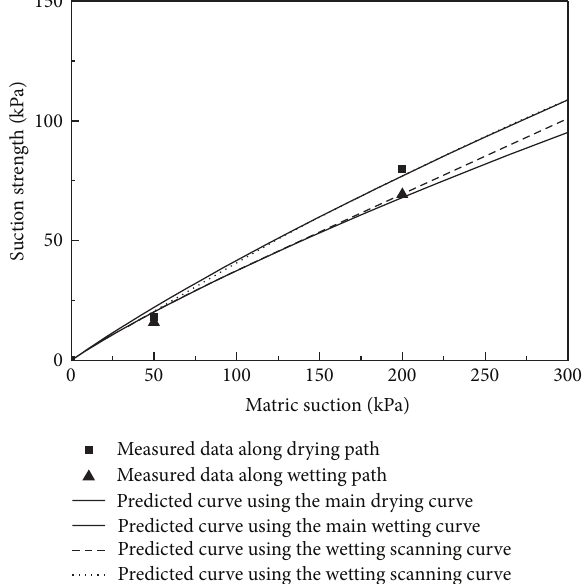
Figure 9: Comparison of tested data with the predictive curve of suction strength under drying-wetting paths (measured data from Goh et al.